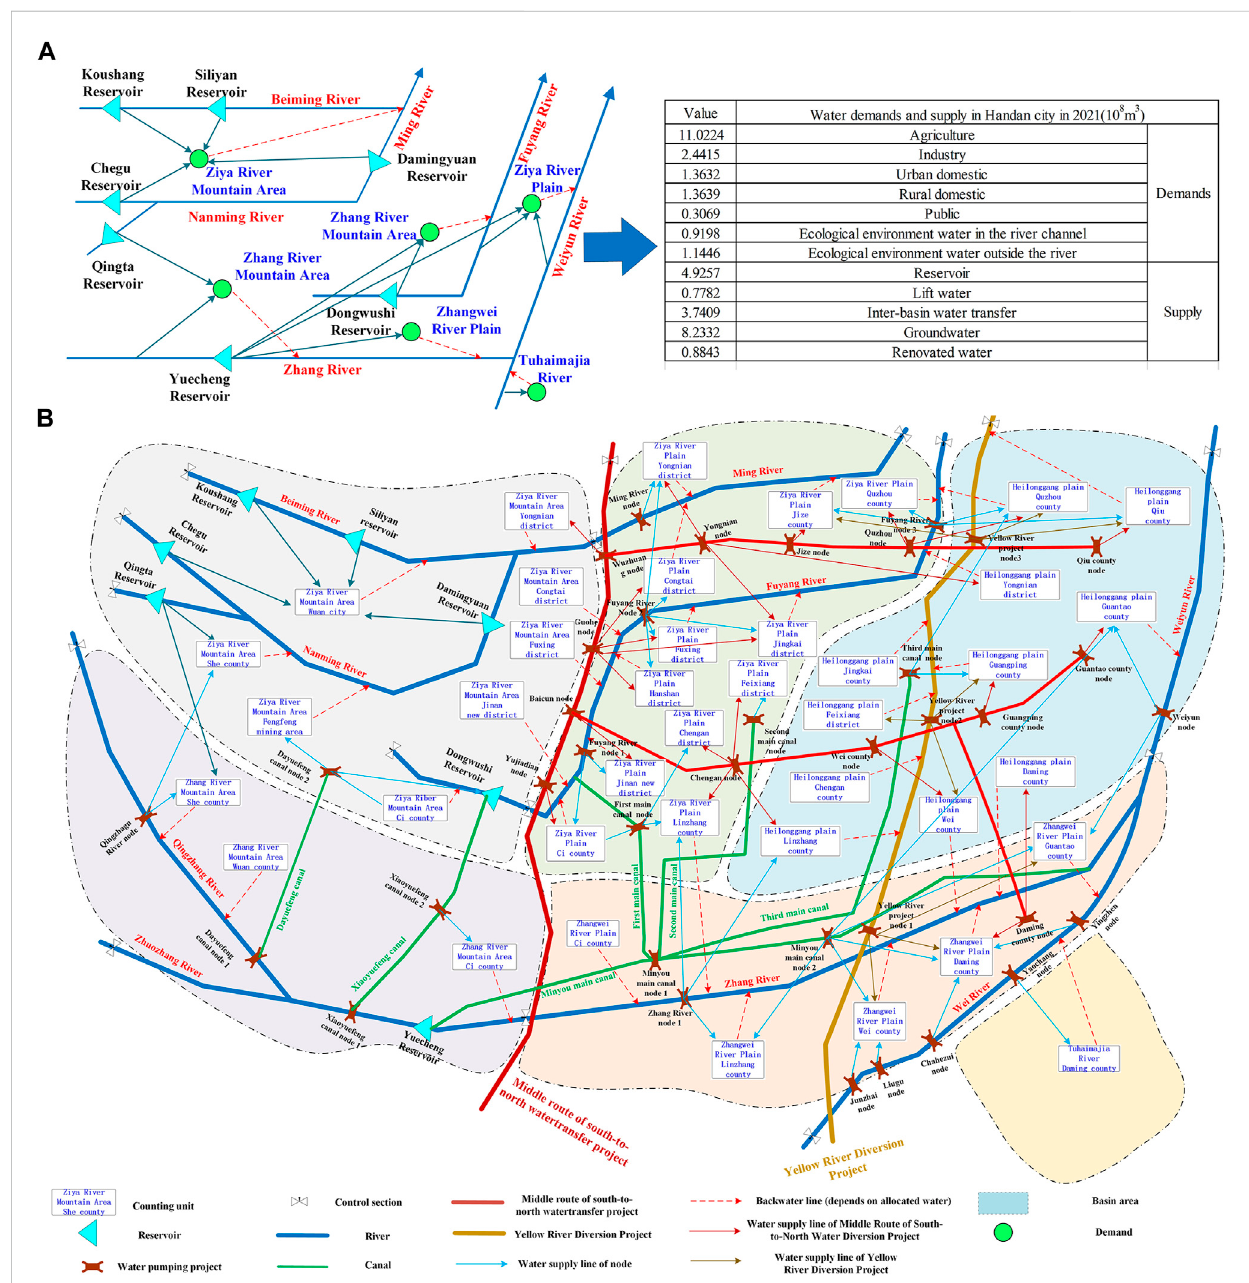
FIGURE 7 Water allocation network map. (A) The relationship between water supply and water consumption in Handan in 2021 (B) Water allocation network map in Handan.